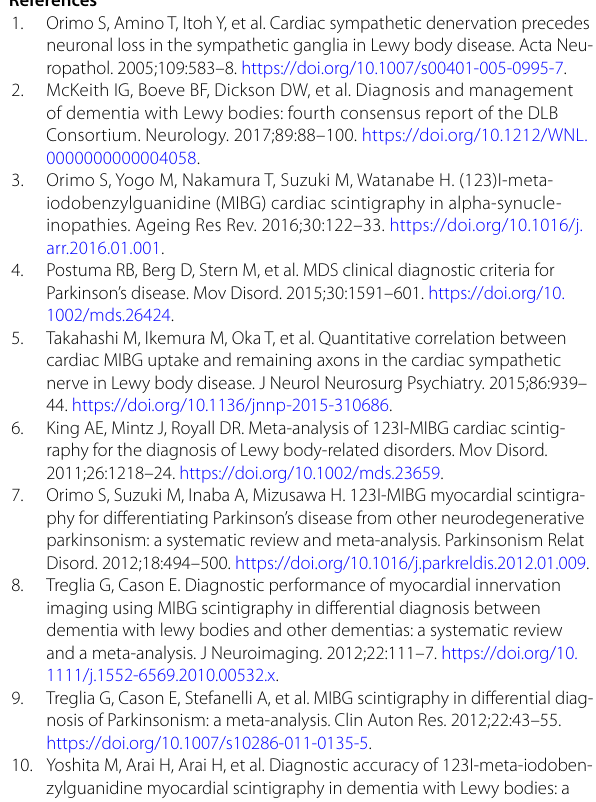
tary Figure 2 . The plasma input functions (PIFs) and tissue TACs (tTACs) obtained from the two representative patients from Figure 1. APPENDIX .